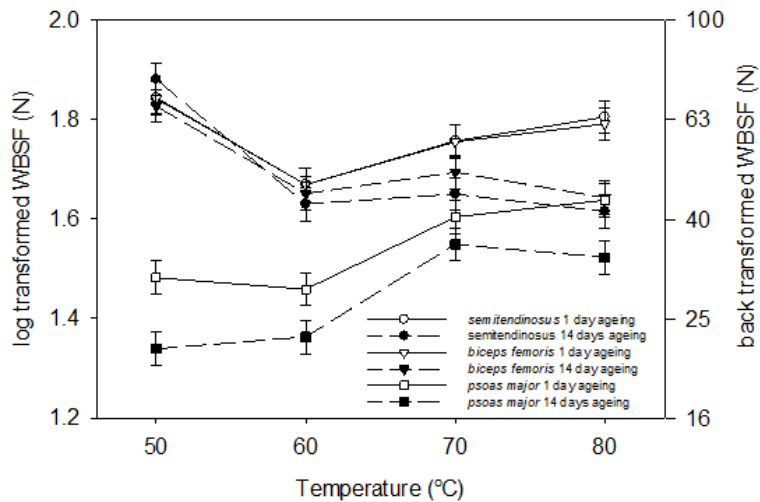
Figure 2. Effect of ageing (1 day post mortem vs. 14 days post mortem) and cooking temperature (50 ◦ C, 60 ◦ C, 70 ◦ C and 80 ◦ C) on Warner–Bratzler shear force (WBSF) of bovine semitendinosus , biceps femoris and psoas major . Cooking time was 30 min. after reaching the defined temperature (Tc + 30 min). Primary y-axis depicts means obtained by analysis of log-transformed data, and secondary y-axis shows back-transformed values of the primary axis. p (muscle) < 0.001, p (ageing) = 0.006, p (temperature) < 0.001, p (muscle × ageing) = 0.78, p (muscle × temperature) < 0.001, p (ageing × temperature) < 0.001, p (muscle × ageing × temperature) = 0.013.